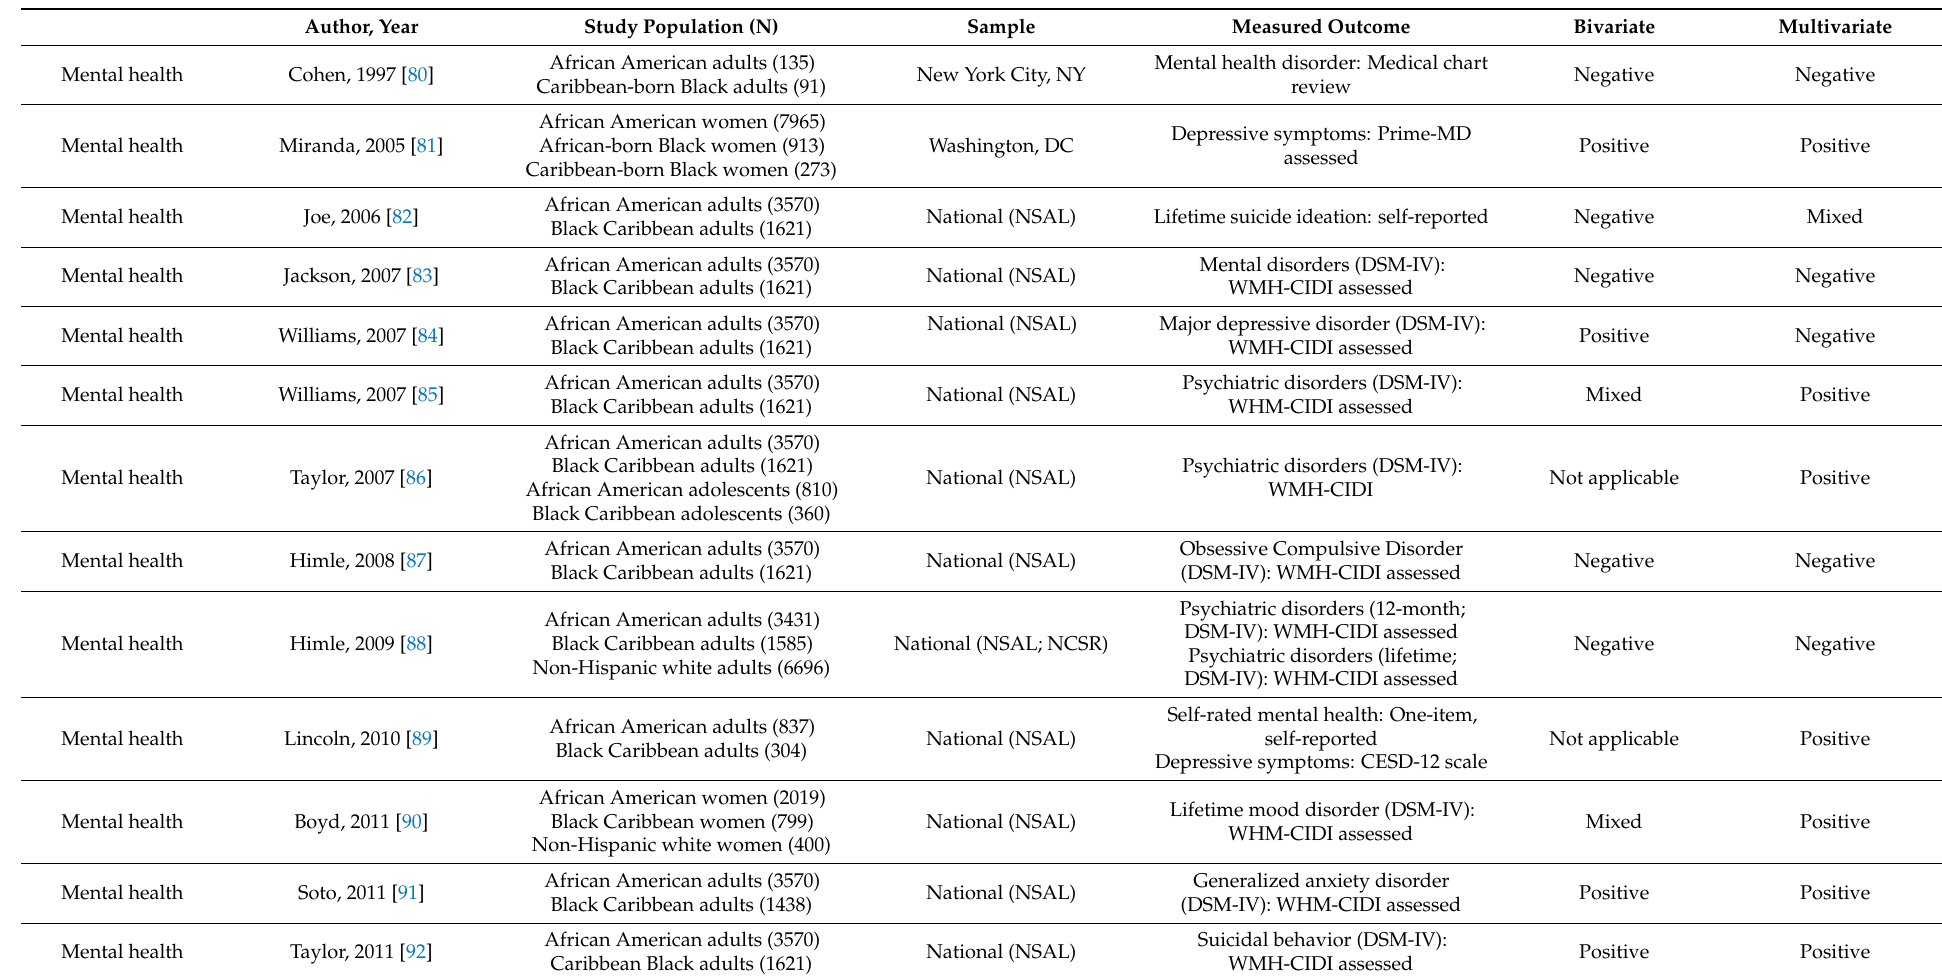
Table 1. Stress, behavior and